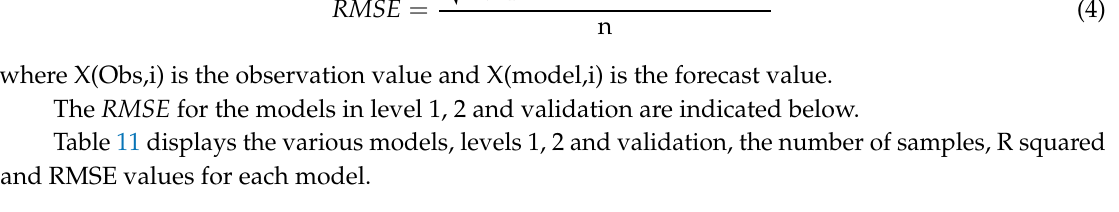
Table 11. R square and RMSE